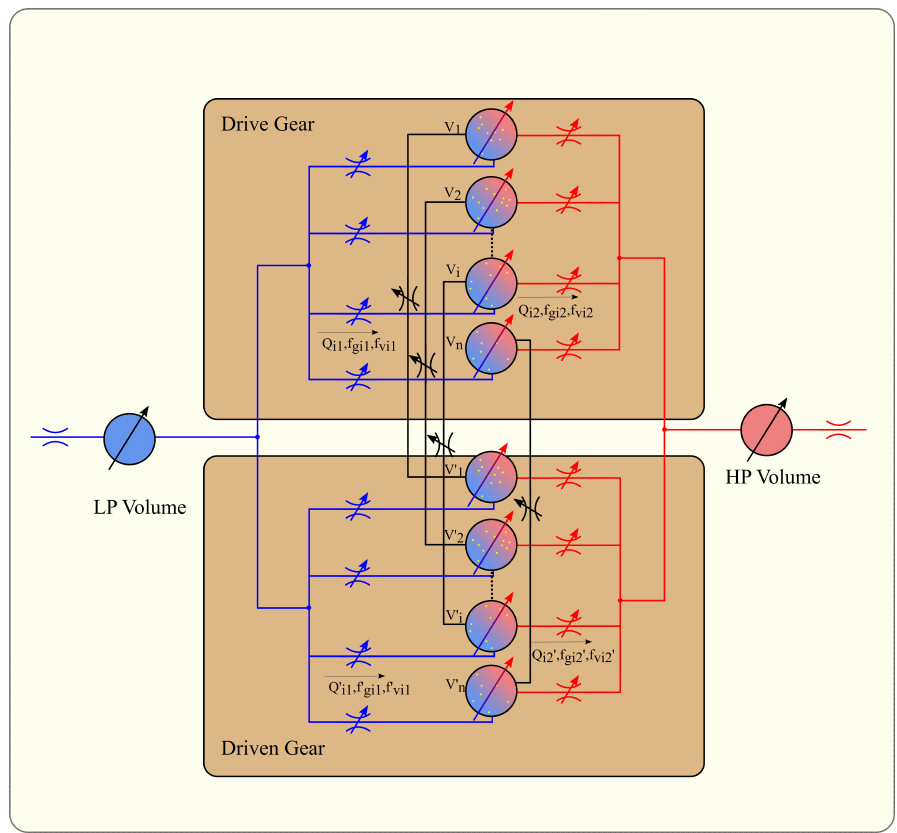
Figure 13. Simplified representation of an External Gear Machine along with the CVs and orifice